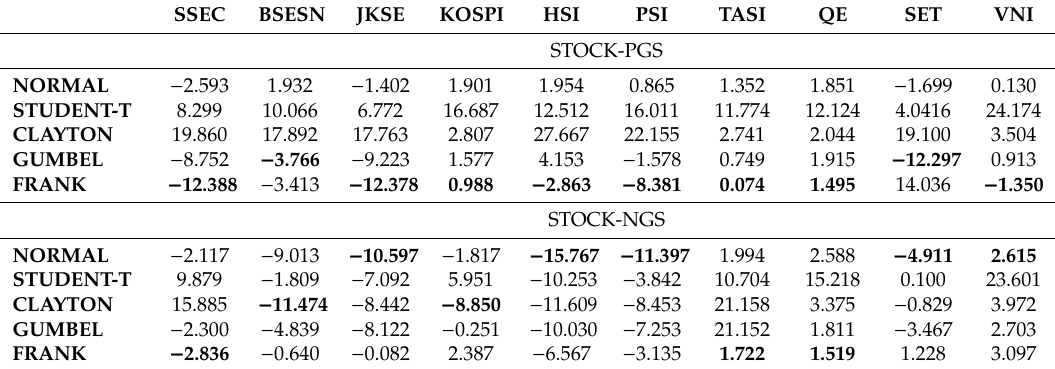
Table 7. Static Copula selection based on Akaike information criterion